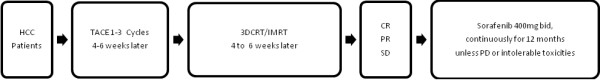
Treatment Schedule.